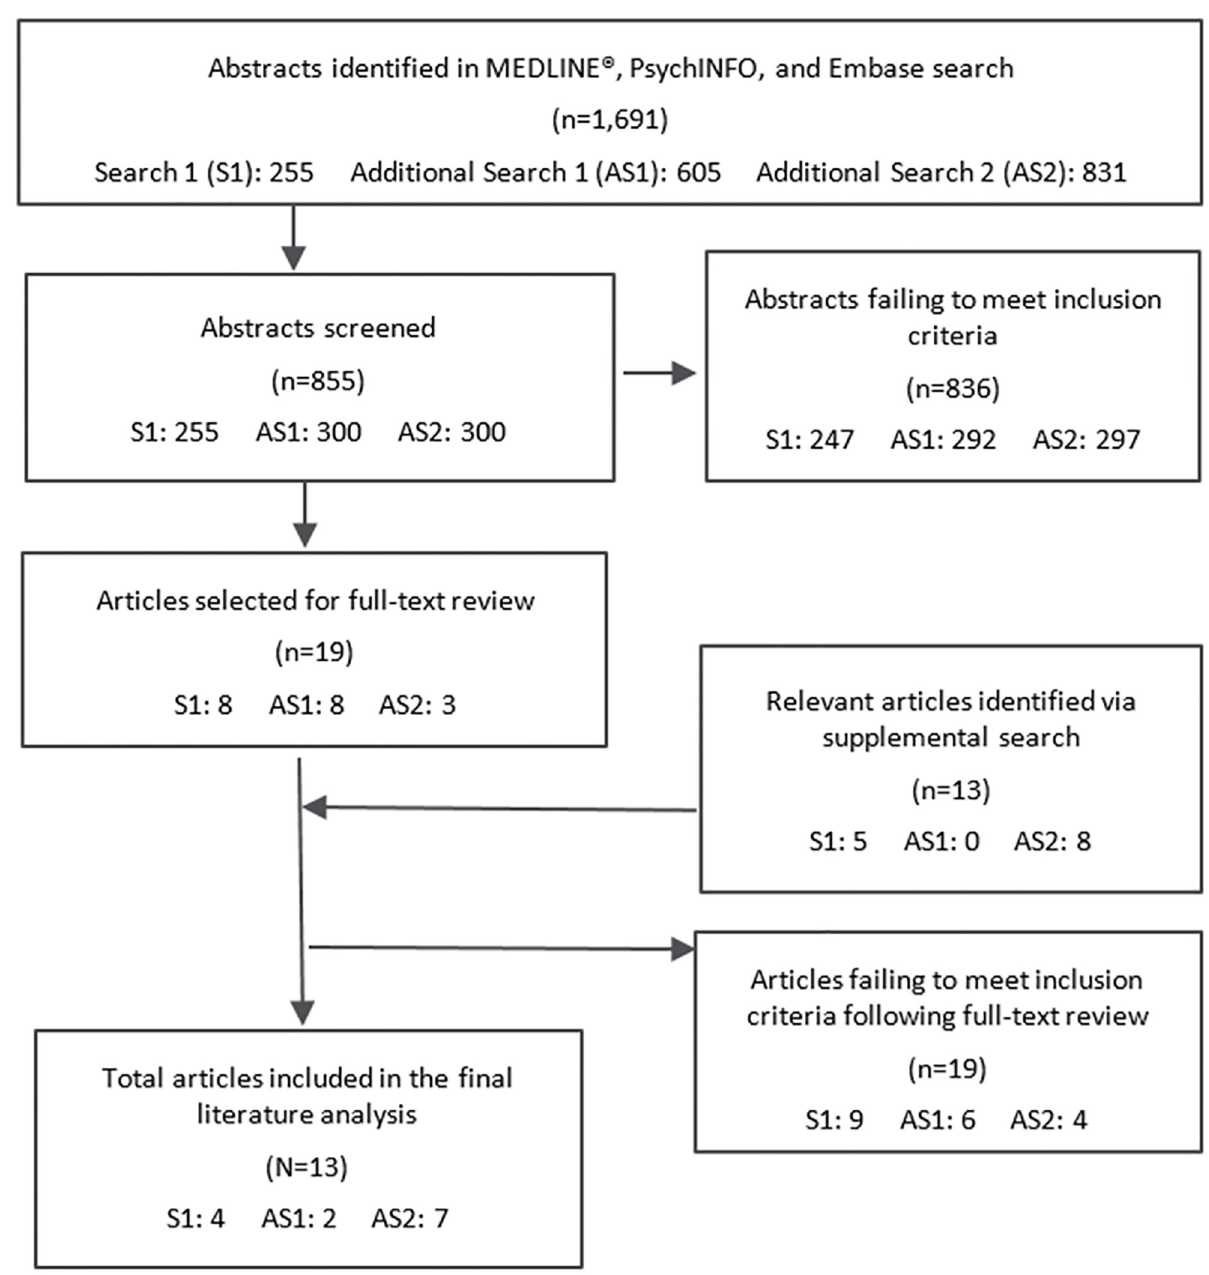
Fig 1. Search flow diagram for the selection of publications reviewed. Note: S1 = Search 1; AS1 = Additional Search 1; AS2 = Additional Search 2.